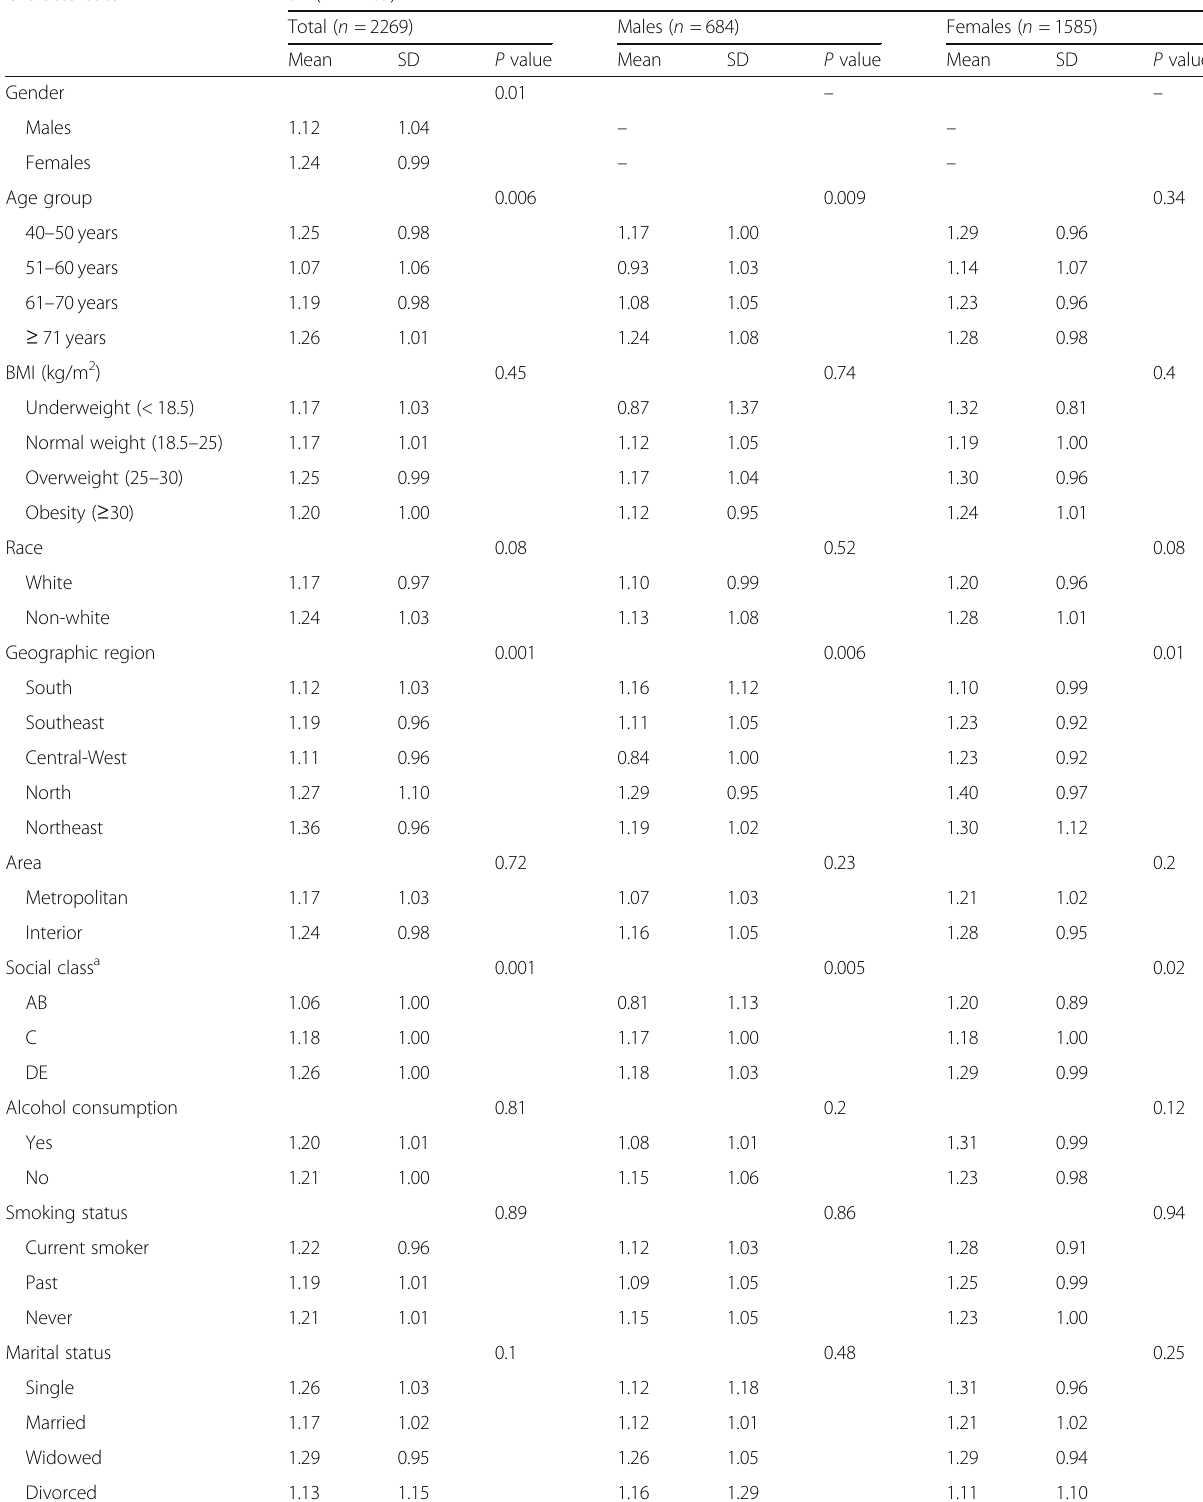
Table 3 Dietary Inflammatory Index according to the characteristics of the participants